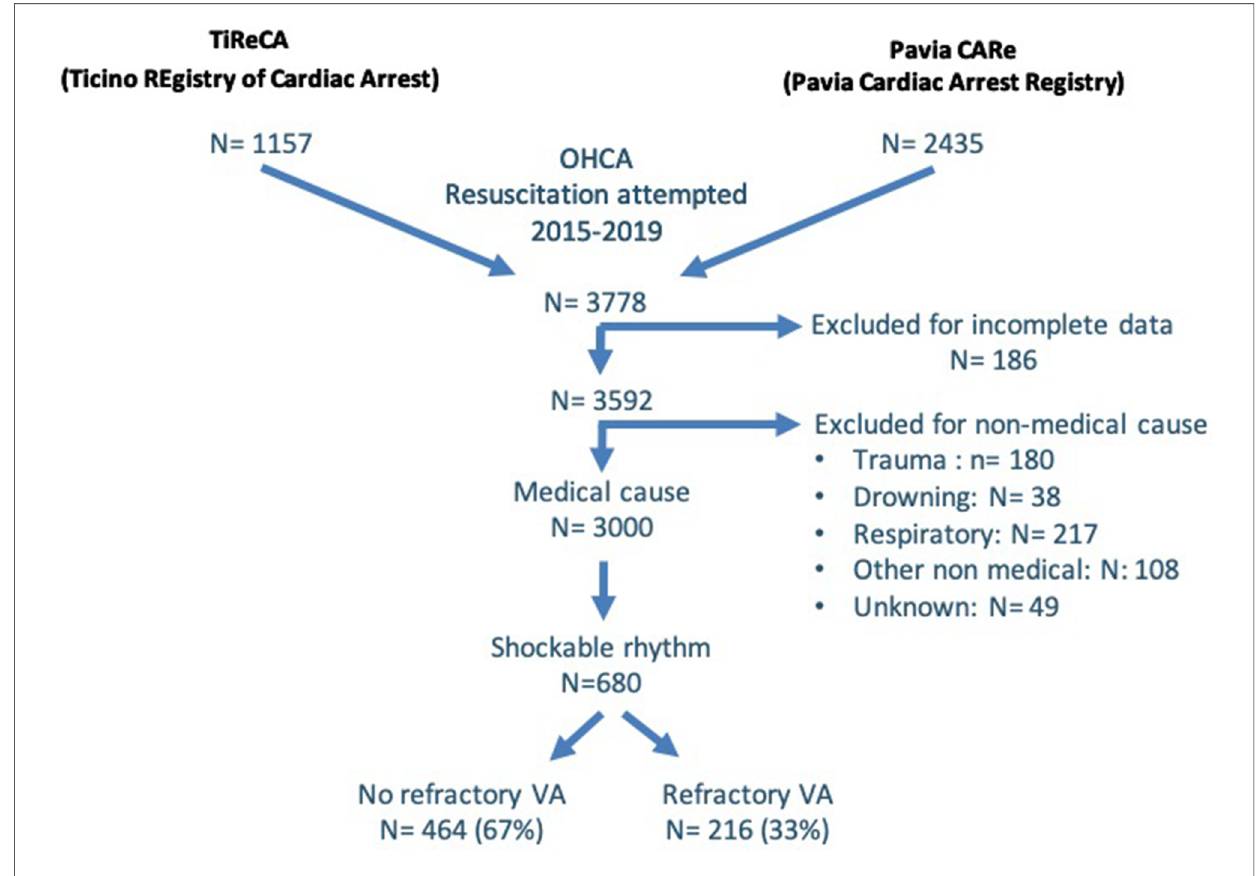
FIGURE 1 Flow chart of patients ’ inclusion